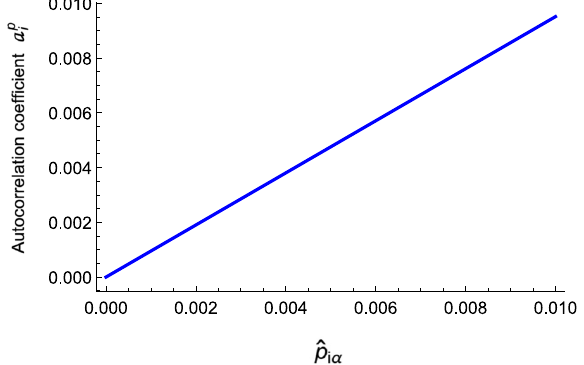
Fig. 2 The relation function between a p and ^ p i α . The same values i are given to the parameters of the detectors. We assume that pulses with coherent states that contain the mean photon number ν = 1 insert SPDs with detection ef fi ciency η α = 0.1, e d α = 6 × 10 − 7 and ^ p : 05 . For ideal devices, the prior autocorrelation coef fi cient α ¼ 0 should be